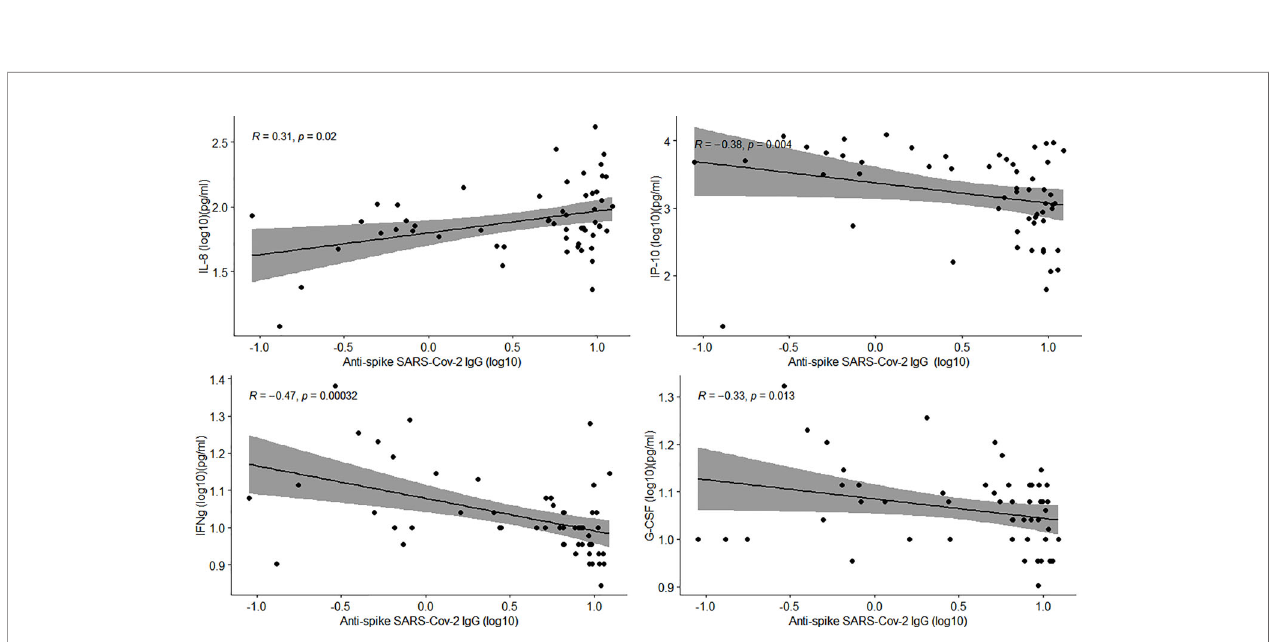
FIGURE 4 | Correlation of anti-spike IgG antibody levels and biomarker concentrations in COVID-19 patients. Scatter plots show statistically signi fi cant correlations between biomarkers and antibody levels. Rho value and p-vale were computed by Spearman correlations. The shaded area shows the 95% con fi dence